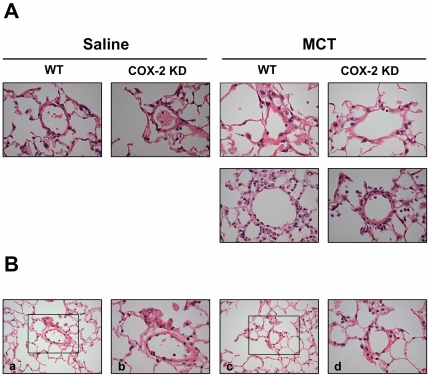
Minimal vascular pulmonary remodeling after MCT.A. Representative images 400x indicating only mild thickening of pulmonary arterioles from WT and COX-2 KD mice after MCT compared to saline. Lower panels are representative of WT and COX-2 KD MCT-treated mice that required euthanasia. Sections were stained with H&E. Lungs from 38 mice were evaluated microscopically with 2 lung sections/mouse, as follows: WT/saline, n = 6; COX-2 KD saline, n = 6; WT/MCT, n = 14; COX-2 KD/MCT, n = 12. B. Representative photomicrographs at 200x (a, c) of lung sections from a COX-2 KD MCT-treated mouse showing pulmonary mild perivascular edema with neutrophil infiltration in small arterioles. Boxed areas from a and c are shown at 400x in b and d.